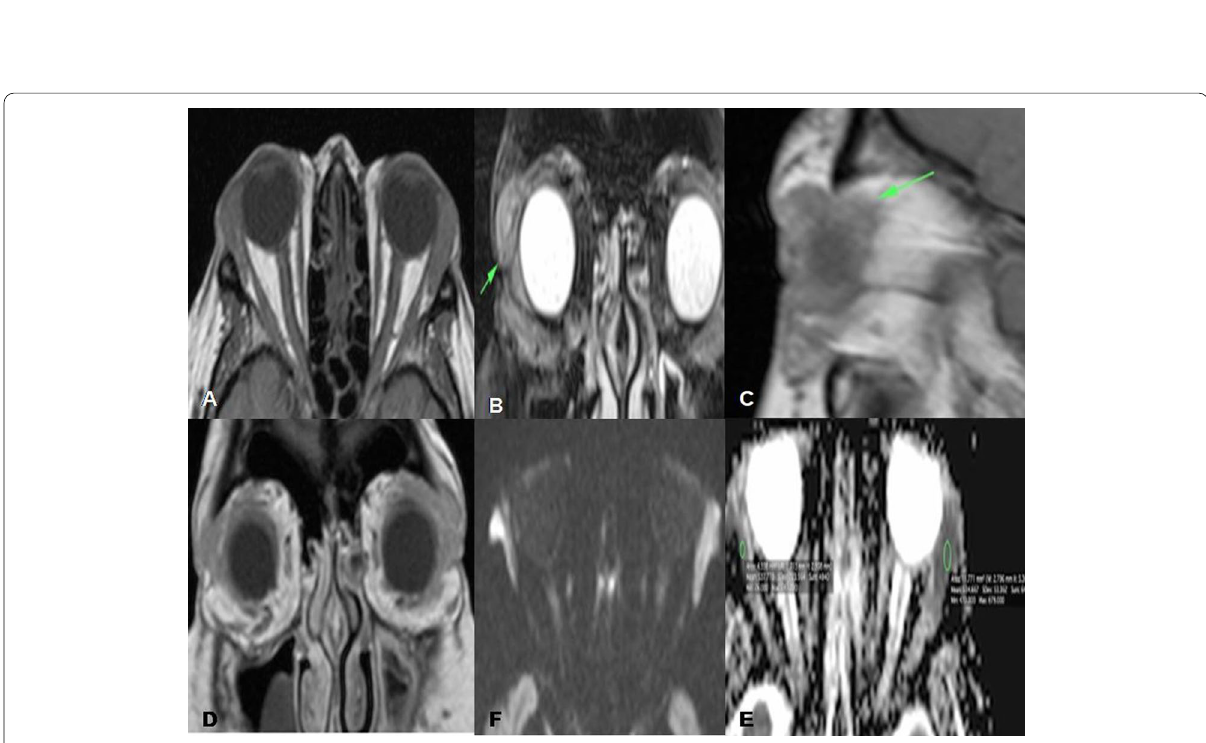
Fig. 9 A 57-year-old male bilateral dull aching orbital pain, epiphora and cervical lymphadenopathy. Axial T1 image A shows T1 hypointense infiltrative masses involving both lacrimal glands. Coronal T2 image B revealed hyperintense signal of the lesions. Sagittal T1 post-contrast C reveals homogeneous mild enhancement of the previously mentioned both lacrimal gland masses. (arrow) Coronal T1 post-contrast image D shows mild enhancement of the lacrimal gland lesions. Evident diffusion restriction on DWI (b 1000 )/ADC ( E , F ). The ADC value for the left mass is 0.53 − 3 mm 2 / sec ( F ). Bilateral lacrimal gland lymphomas, proved by histopathology and hematological